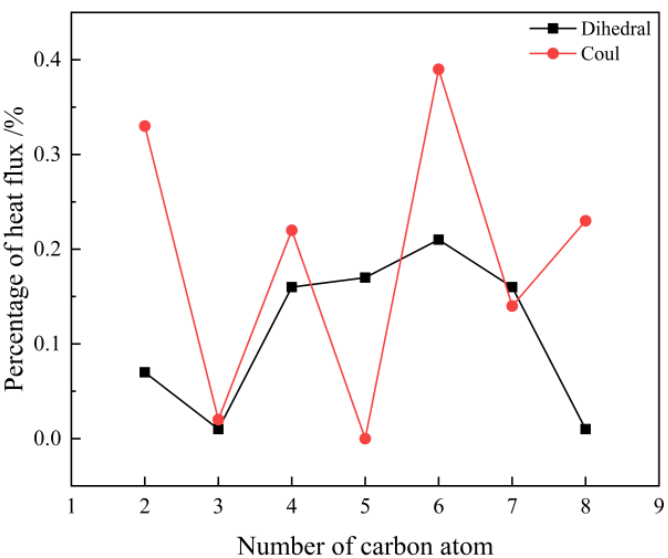
Figure 8. Contribution of energy transfer in dihedral and coul part to the total heat flux for seven species of alcohols at 323.15 K.